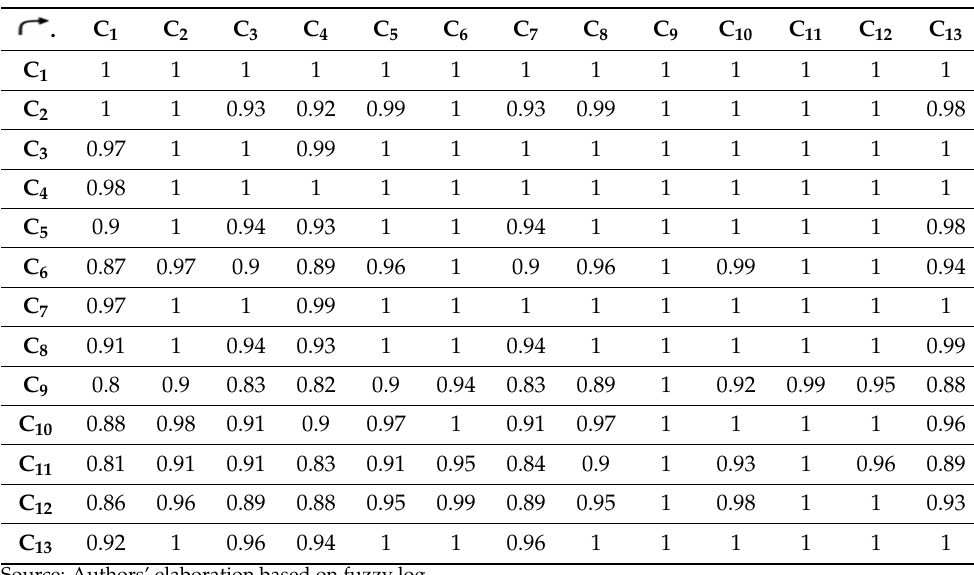
Table 8. Cause–cause estimation matrix [ (cid:101) A ] .